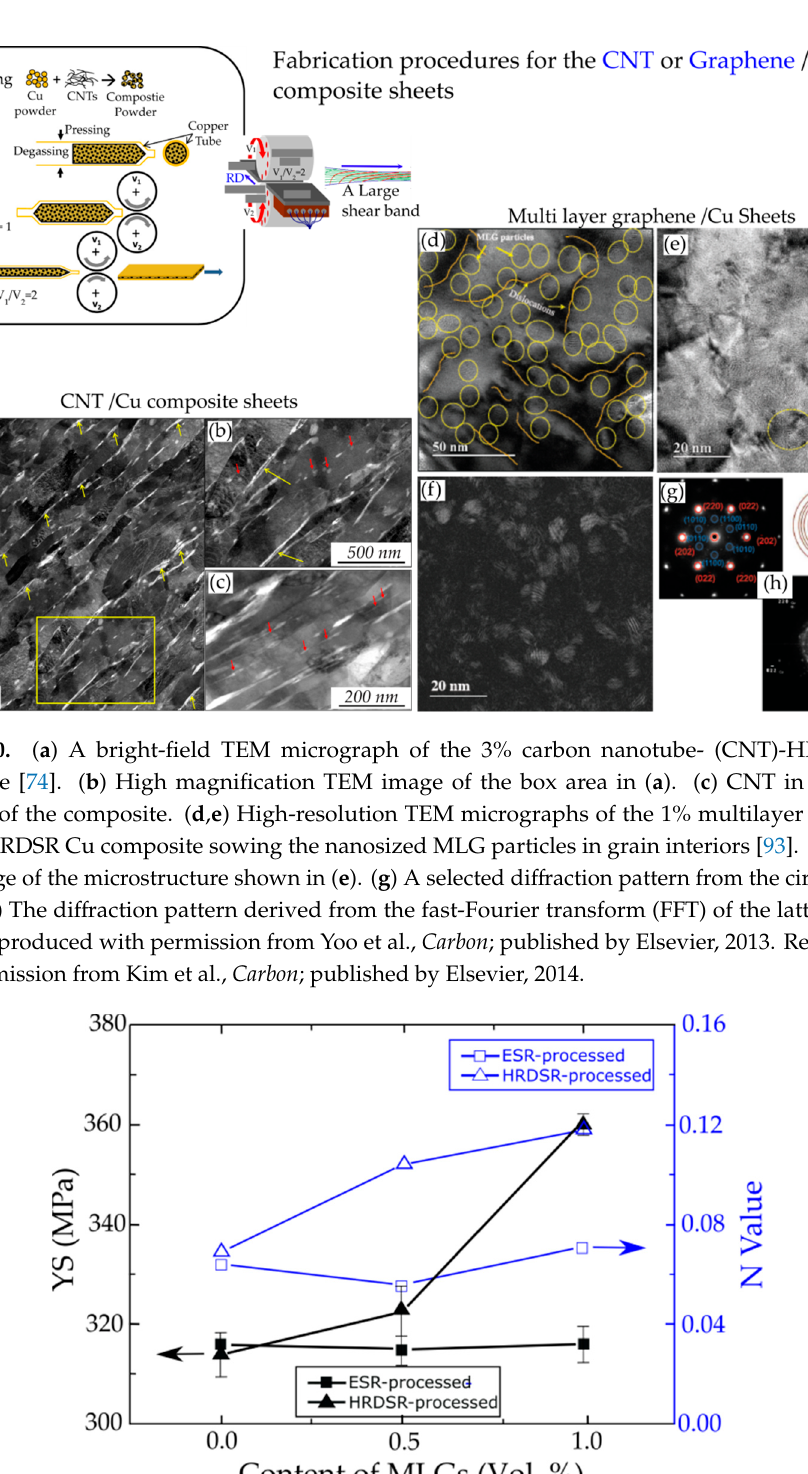
Figure 22. ( a ) Bright-field, ( b ) dark-field and ( c ) high-resolution TEM of Al/TiC/CNT composites [94]. Reproduced with permission from Kim et al., Scr. Mater. ; published by Elsevier, 2014. 4. Summary and Conclusions 1.